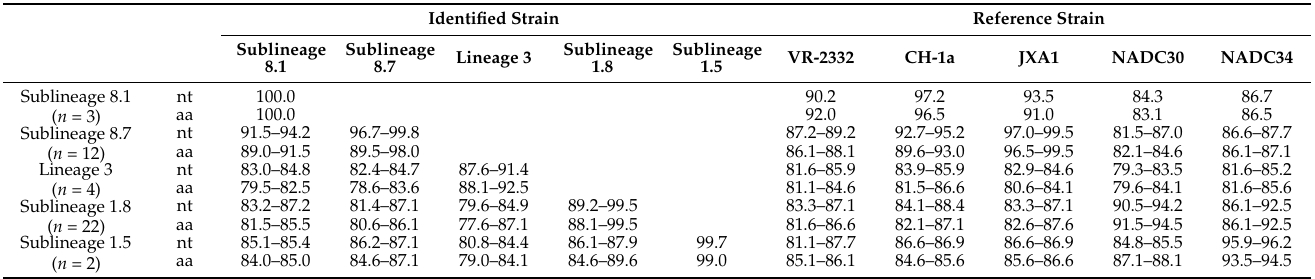
Table 3. Sequence homology (%) in the ORF5 genes of PRRSV strains obtained in this study and the reference